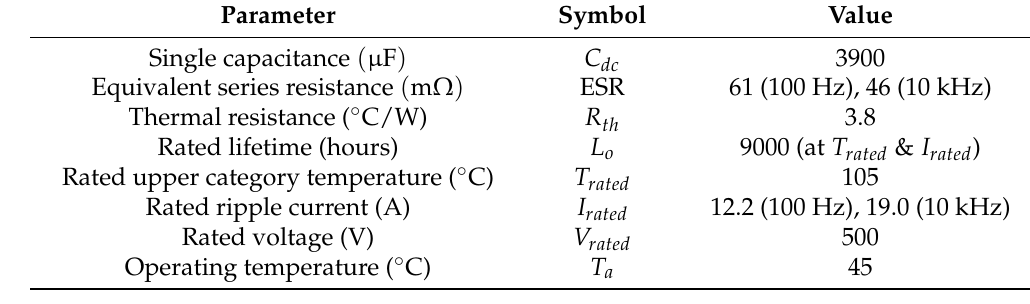
Table 4. Specifications of the DC-capacitor (KEMET − AlS8(1)(2)392NF500).